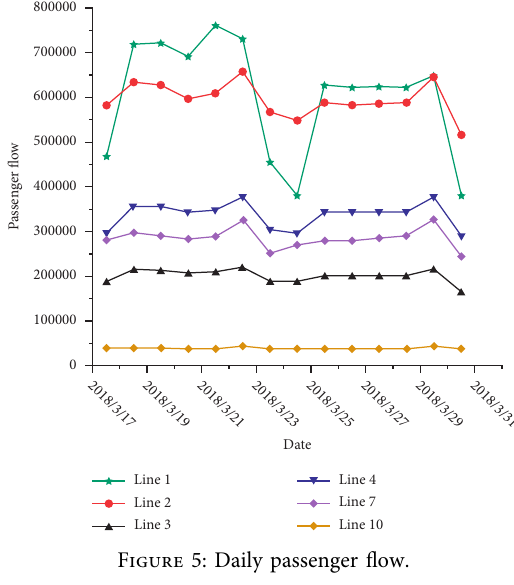
Figure 5: Daily passenger flow.